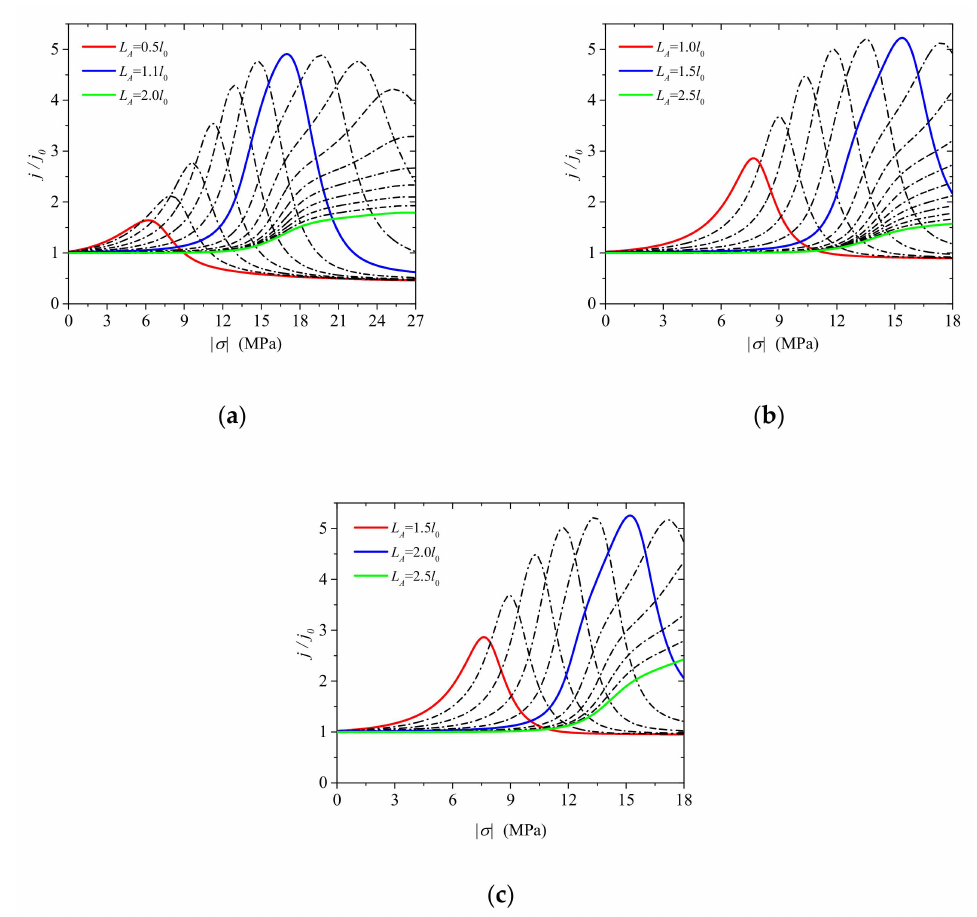
Figure 7. Variations in the output current density (at the PN junction) with stress under conditions of varying MIAPB widths. ( a ) ∆ l / l 0 = 0.2, ( b ) ∆ l / l 0 = 0.5 and ( c ) ∆ l / l 0 =